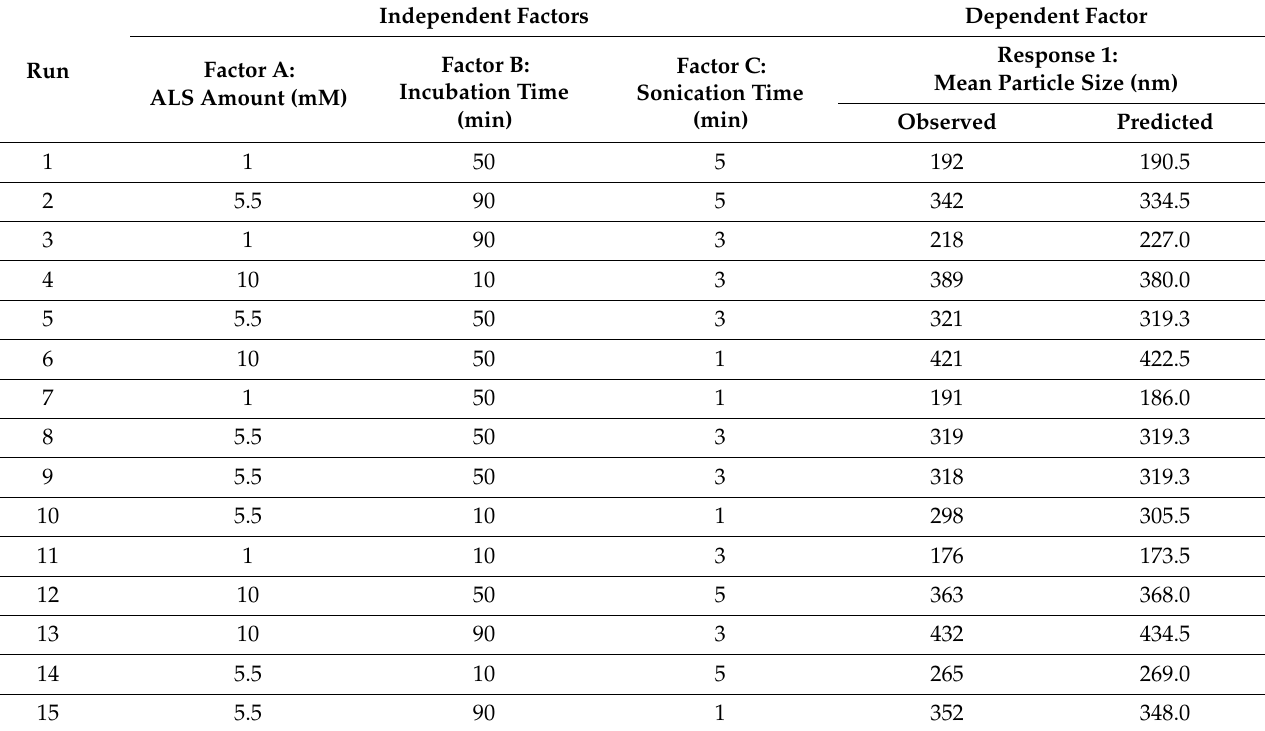
Table 1. The responses obtained (observed and predicted values) for various APA-ALS-NC formulation